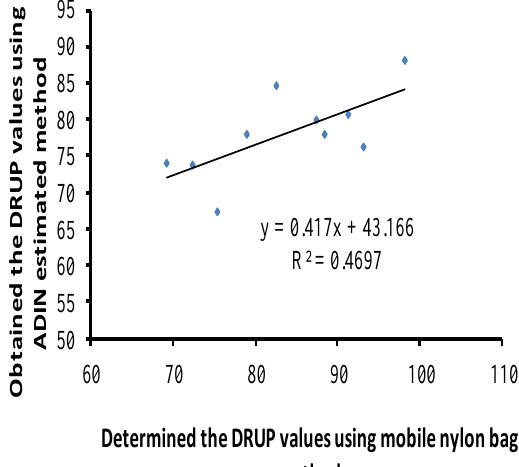
Figure 7. Predicted analysis between MNB determined values and ADIN estimated values in the concentrates. DRUP, digestibility of rumen undegradable protein; MNB, mobile nylon bag method; ADIN, acid detergent insoluble nitrogen